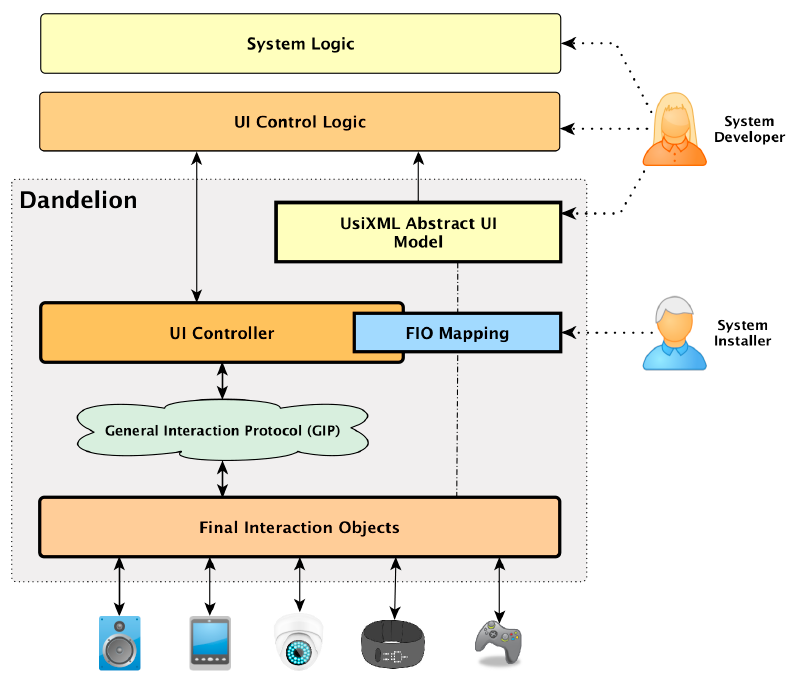
Figure 2. Dandelion detailed architecture block diagram.